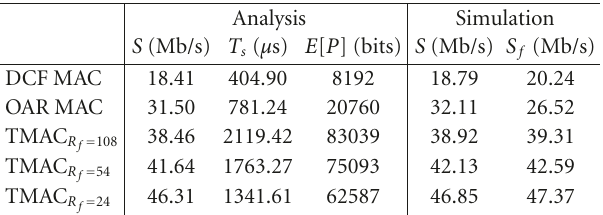
Table 2: Comparison of TMAC, DCF, and OAR. Analysis